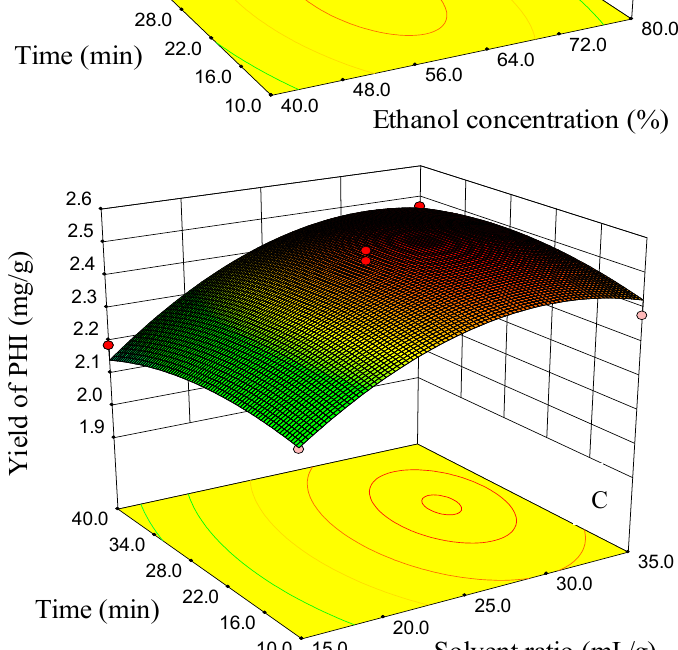
Figure 10. Response surface and contour plots for the effect of ( A ) EtOH concentration/solvent ratio, ( B ) EtOH concentration/time and ( C ) time/solvent ratio on the yields of phillyrin (PHI).